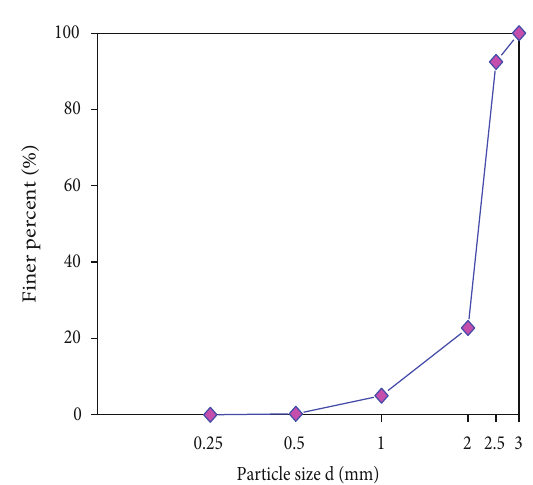
Figure 2: Particle grading curve of indoor samples and numerical